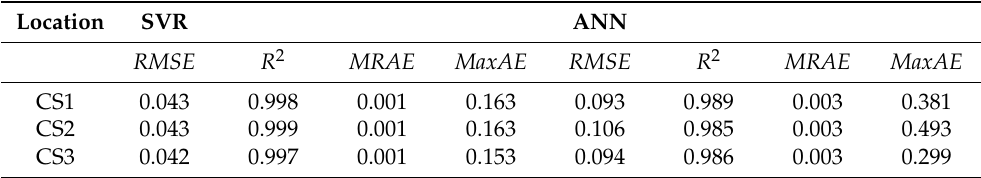
Figure 7. Absolute correlation values resulting from Kendall, Pearson, and Spearman tests and percentage of contribution (PC) values resulting from ANOVA test (Equation (10)). The results of the different implemented techniques presented in Figure 7 indicate a significant correlation between rainfall ( i p ) and water level followed by river friction ( K s _R ) and forest runoff coefficient ( C_F ). The findings of the correlation tests and ANOVA test are consistent; however, the ANOVA results are more stable at different locations